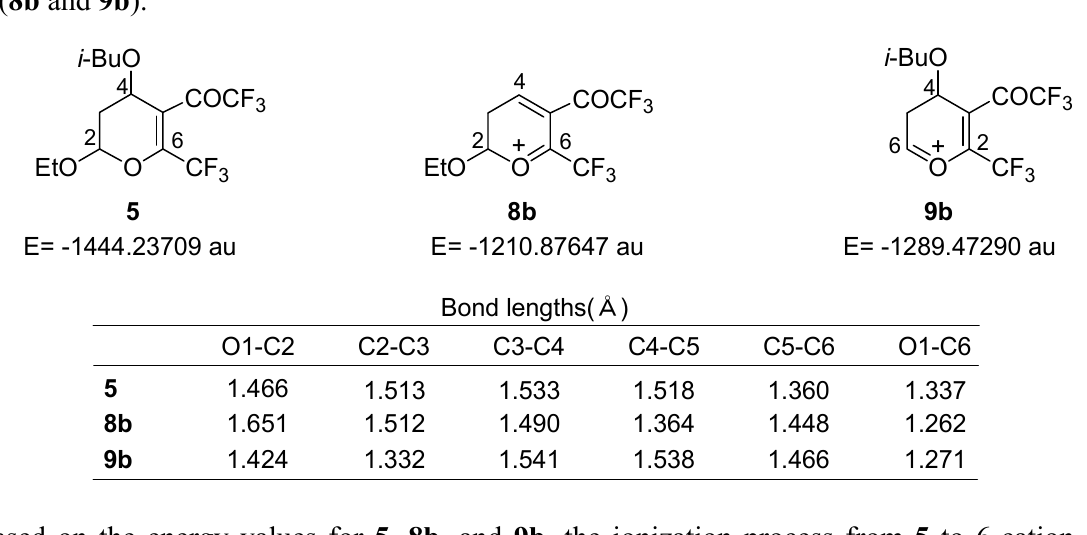
Figure 4. Optimized structures and energy values of dihydropyran ( 5 ), and cations ( 8b and 9b